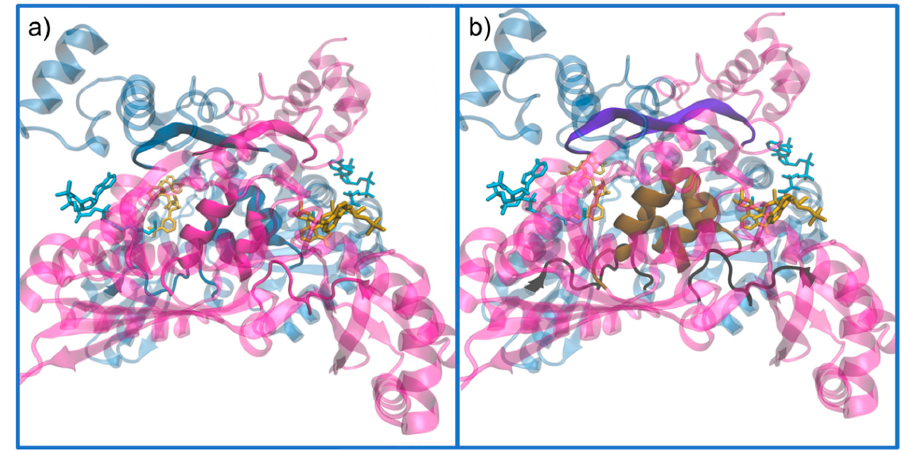
Figure 8. Demonstration of the dimer interfaces. These structures follow the representation and color code of the dimer in Figure 7, as chain A and B are colored in magenta and blue (transparent to better see details), respectively. ( a ) The monomer–monomer interactions are detailed by chain; and ( b ) the